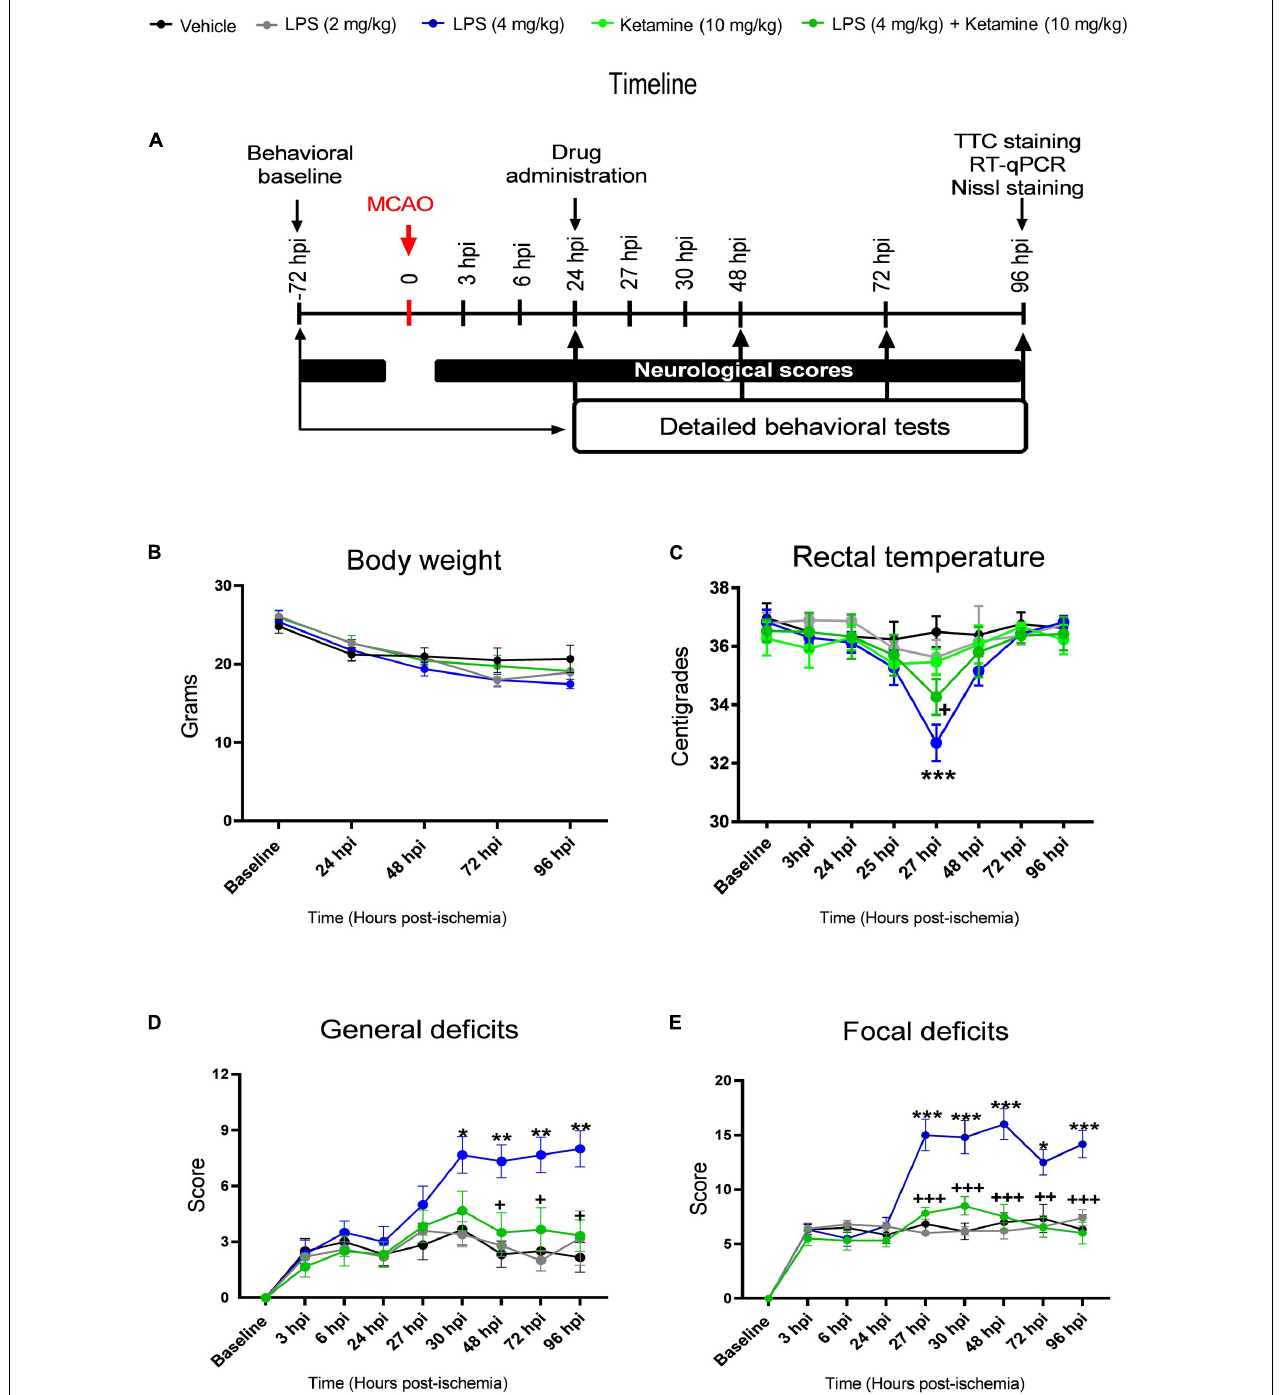
FIGURE 1 | Effects of LPS and ketamine on post-ischemic body weight, rectal temperature, general and focal neurological scores. (A) Timeline of the experimental procedure, (B) body weight, (C) rectal temperature, as well as (D,E) general and focal neurological deficits assessed by the Clark score in mice exposed to transient intraluminal middle cerebral artery occlusion (MCAO) which were intraperitoneally injected with vehicle or LPS (2 or 4 mg/kg) at 24 h post-ischemia (hpi). 30 min later, vehicle or ketamine (10 mg/kg) was intraperitoneally administered in mice receiving vehicle or LPS (4 mg/kg). Note that LPS at 4 mg/kg, but not 2 mg/kg, induced hypothermia at 27 hpi (that is, 3 h after LPS injection), indicative of a sepsis-like state, and exacerbated general and focal neurological deficits in the Clark score. Ketamine attenuated the LPS-induced rectal temperature reduction and reversed the general and focal neurological deficits, whereas ketamine alone did not influence rectal temperature or neurological scores. Data are mean ± SEM values ( n = 6 animals/group). * P < 0.05; ** P < 0.01; *** P < 0.001 compared with ischemic vehicle; + P < 0.05; ++ P < 0.01; +++ P < 0.001 compared with ischemic LPS (4 mg/kg).